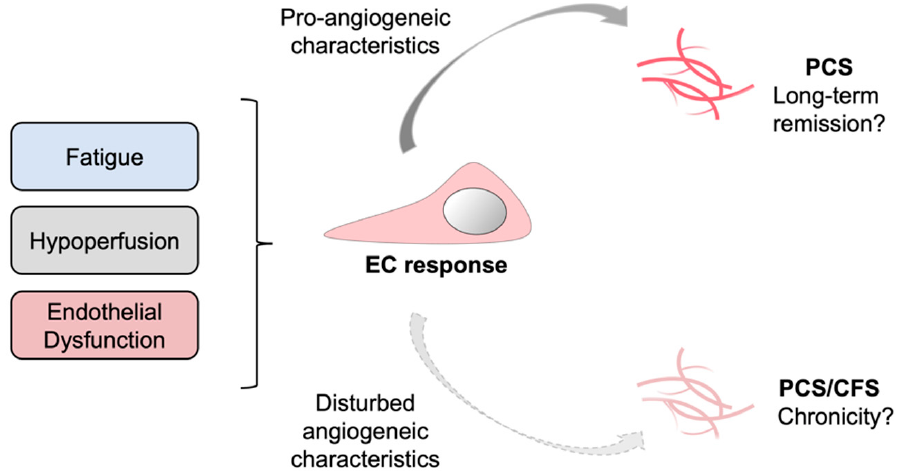
Figure 5. Schematic representation of a putatively suppressed angiogenic response in PCS versus PCS/CFS patients. In response to certain clinical manifestations in PCS and PCS/CFS, specifically microvascular hypoperfusion and local endothelial dysfunction, a systemic counterreaction could be triggered which directly affects endothelial cells (EC) and promotes angiogenesis. This compensatory EC response is likely to differ among PCS and PCS/CFS patients as shown in this study by a distinct secretion profile and angiogenic response of HUVECs following serum incubation.